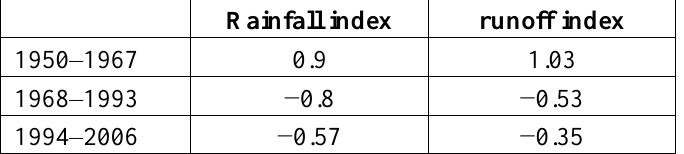
Table 5. Evolution of rainfall and runoff indexes of the Niger River at Koulikoro